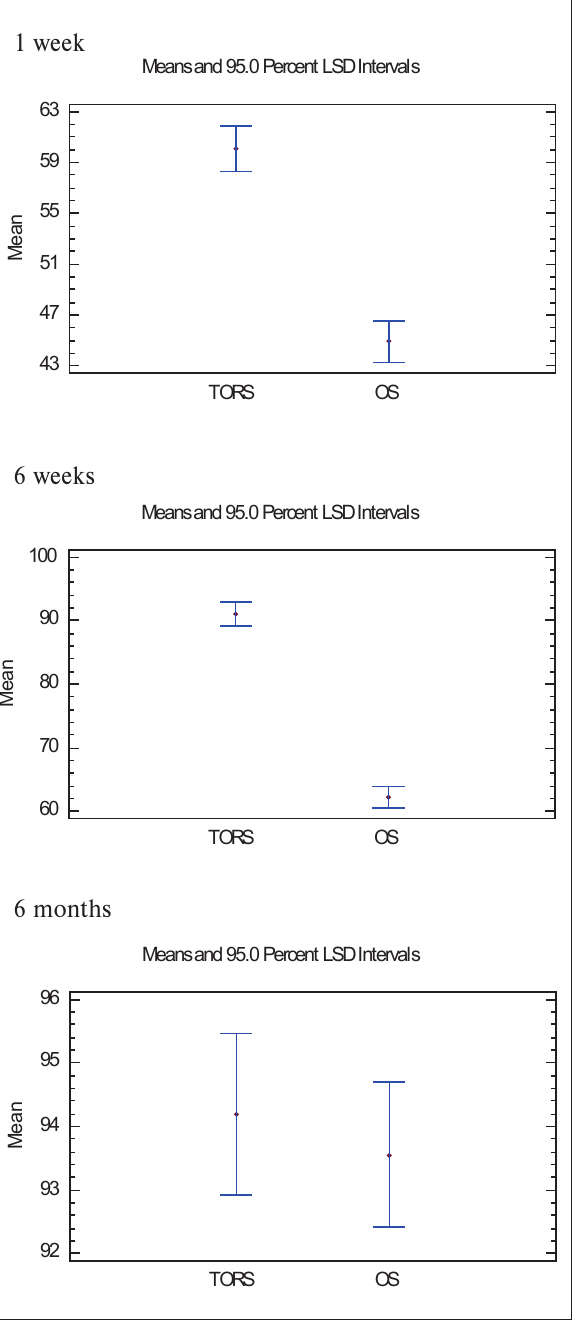
Fig. 3. Vas scores in the selected intervals in Tors and